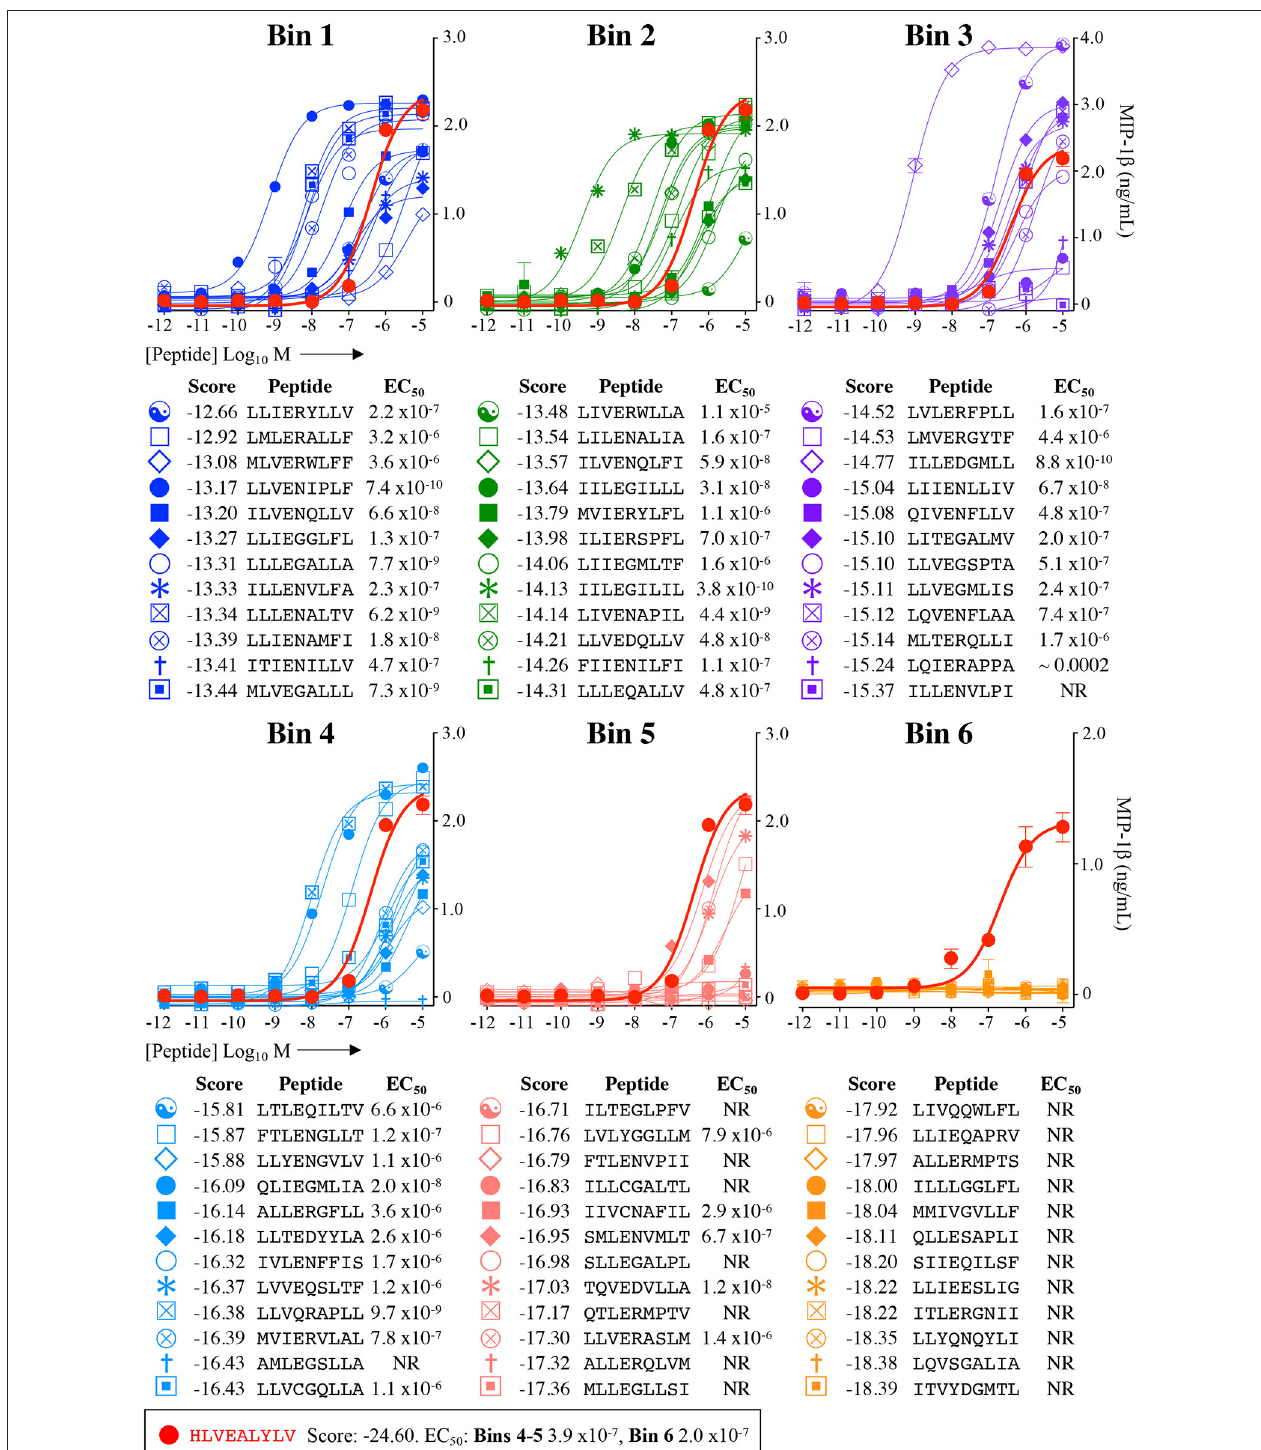
FIGURE 6 | Recognition of 72 randomly chosen and uniformly distributed bacterial peptides by the InsB4 T-cell clone. Each panel shows results of MIP-1 β assay, indicating activation of T-cell clone InsB4 by 12 peptides and the index HLVEALYLV peptide (shown as a bold red line). InsB4 was incubated overnight with the indicated peptides and MIP-1 β released into the supernatants quantified by ELISA. Bins 1-5 were performed in the same assay with Bin 6 performed in a separate experiment hence the different EC 50 values for the index peptide. EC 50 for each peptide (M) is displayed in the tables. NR, no T-cell response. The mean p EC 50 for each bin is plotted in Figure 7A